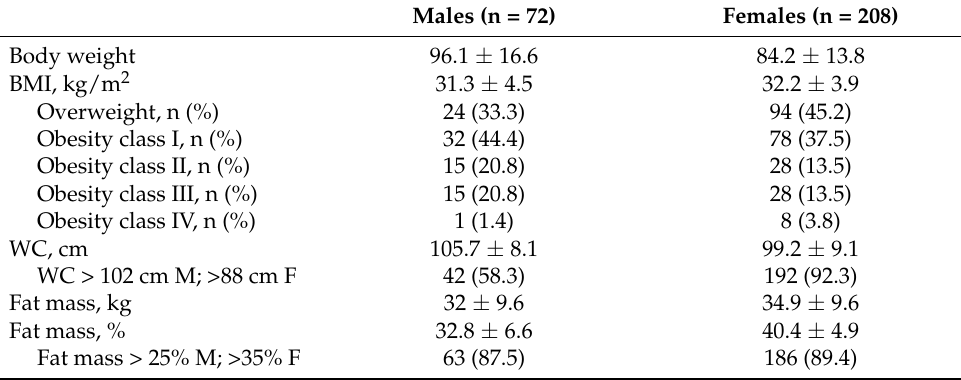
Table 1. Anthropometric characteristics and body